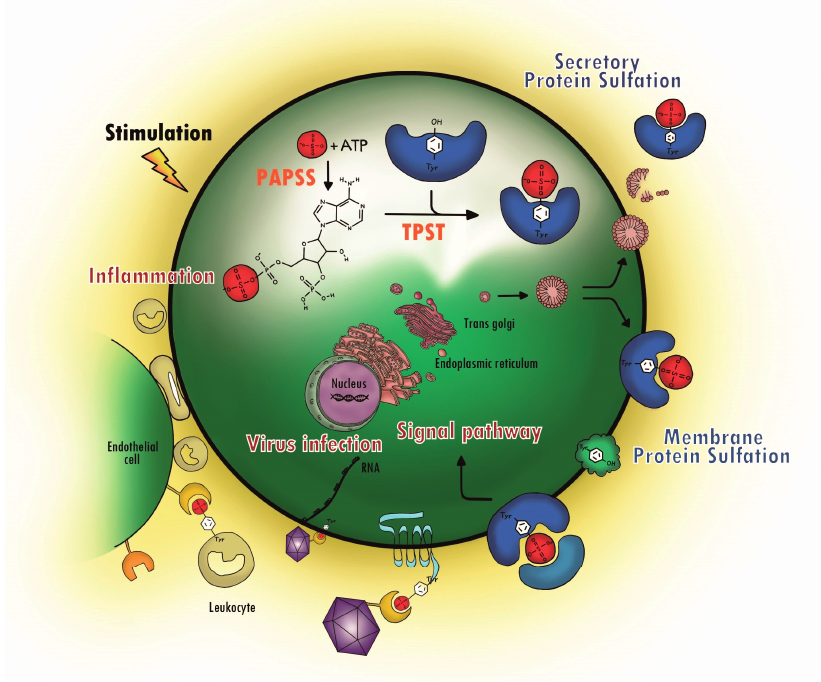
Figure 2. Protein tyrosine sulfation (PTS) and its biological path. The drawing depicts biochemical processes of sulfate in cell, from the activation of inorganic sulfate, its integration into protein and its effects on protein-protein interaction that induces physiological and pathogenic